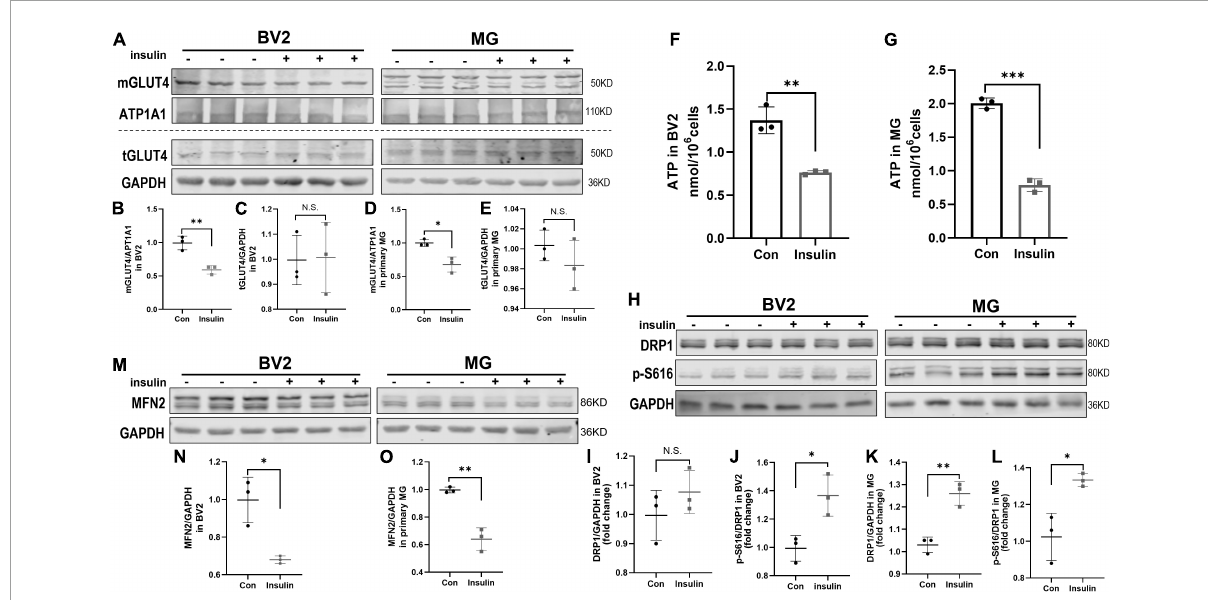
FIGURE5 GLUT4 expression, mitochondrial dynamic, and ATP content in BV2 cells and primary microglia after insulin treatment in vitro . (A–E) Membranous and total GLUT4 expressions in BV2 cells and primary microglia. (A) Representative blot images for membranous and total GLUT4 expression in cells. ATP1A1 and GAPDH served as equal loading controls for membranous and total protein, respectively. (B–E) The corresponding densitometry of membranous and total GLUT4 expression in BV2 and primary microglia cells (fold change of control group). (F) Intracellular ATP content in BV2 cells. (G) Intracellular ATP content in primary microglia. (H) Representative blot images of Western blot for total DRP1 and p-DRP1 S616 in BV2 cells and primary microglia, GAPDH served as an equal loading control. (I–L) The corresponding densitometry of total and p-S616/total DRP1 expression in BV2 cells and primary microglia (fold change of control group). (M) Representative blot images of Western blot for MFN2 in BV2 cells and primary microglia, GAPDH served as an equal loading control. (N,O) The corresponding densitometry of MFN2 expression in BV2 cells and primary microglia (fold change of control group). Data are expressed as mean ± SD. ∗ p < 0.05, ∗∗ p < 0.01, ∗∗∗ p < 0.001. n = 3 per